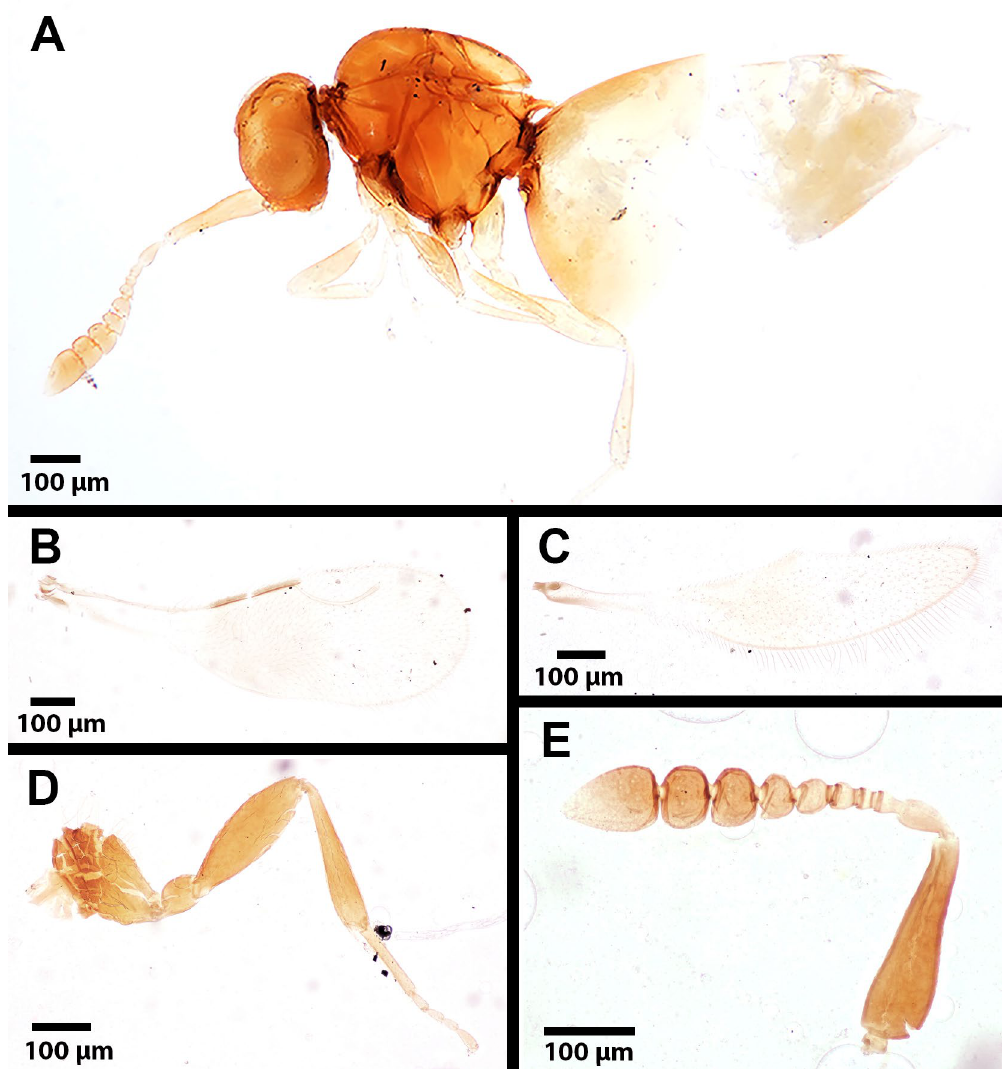
Fig. 5. Aphanogmus fumipennis Thomson, 1858, originally the female type of Ceraphron oriphilus kieffer, 1913, synonymized by Dessart (1966a). A . Lateral habitus of the specimen in ethanol (vial MNhN EY25361). B . Fore wing (slide MNhN EY22433) C . hind wing (slide MNhN EY22433). D . Left posterior leg (slide MNhN EY22432) E . Antenna (slide MNhN